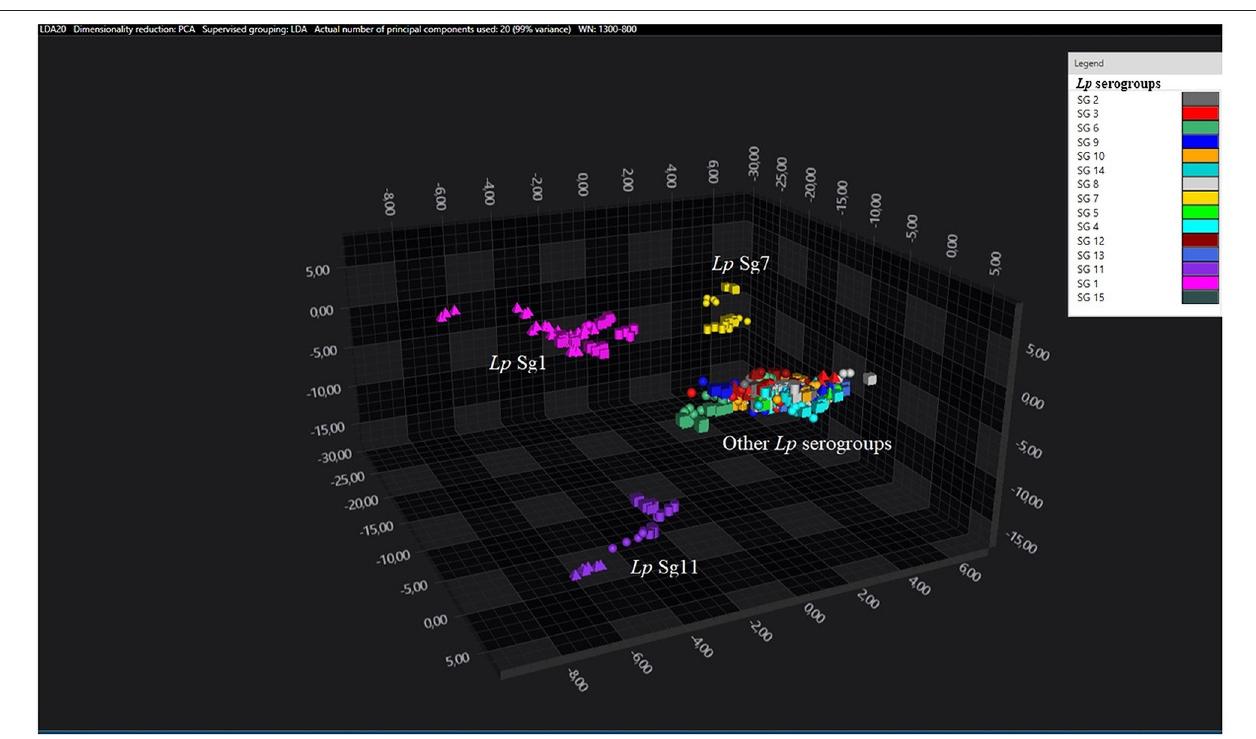
FIGURE 1 | 3D scatter plot representation of ATCC and environmental isolates. LDA was performed with 20 PCs. The single circle, triangle, or square represent one single spectrum (biological and technical replicates). Each serogroup is indicated by a different color. The separation of Sg1 (pink), Sg7 (yellow), and Sg11 (purple) from the other serogroups is well